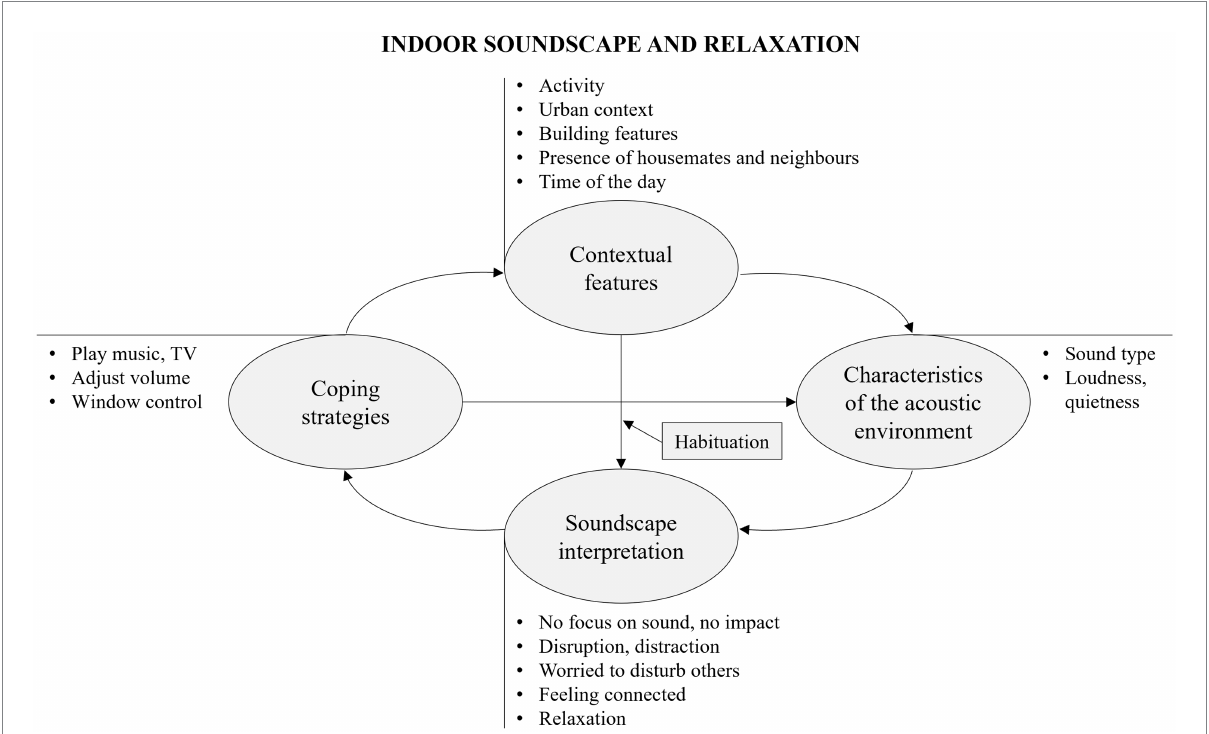
FIGURE 2 Thematic map on the relationship between indoor soundscape and relaxation showing themes (within rounded boxes) and sub-themes, together with their causal interconnections and moderating factors (within squared